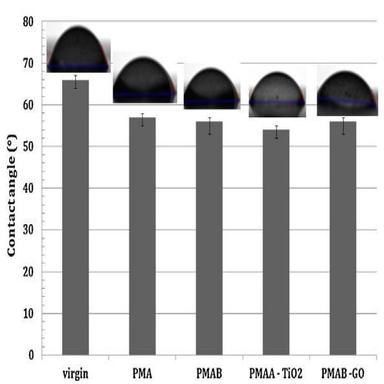
Contact angle measurements of the TFN FO membrane of average of 5 droplets per each membrane.